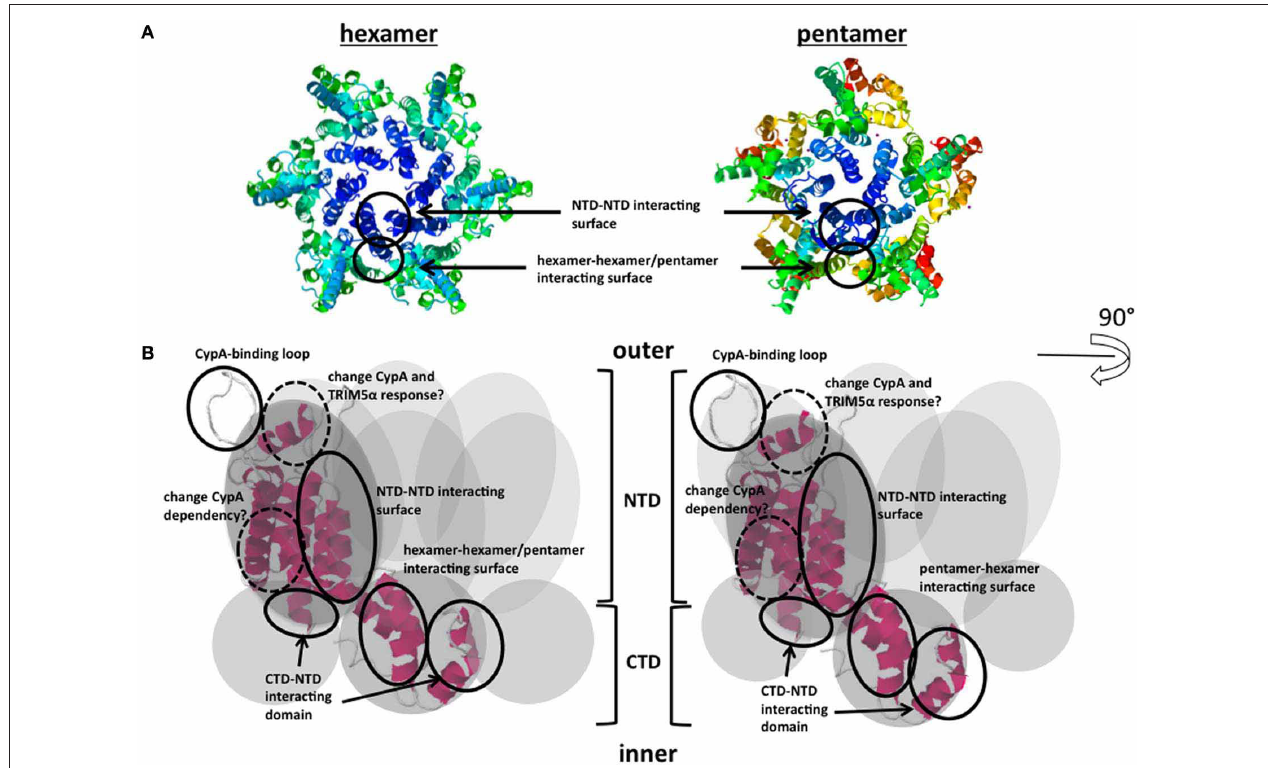
FIGURE 1 | CA proteins form hexamers and pentamers and schematic model of CA interacting domains. (A) Hexameric/pentameric models proposed from structural analysis of the HIV-1 core. Each core comprises approximately 250 hexamers and exactly 12 pentamers. The accession numbers of protein Databases are 3H47, 3P05. (B) Functional surfaces in the